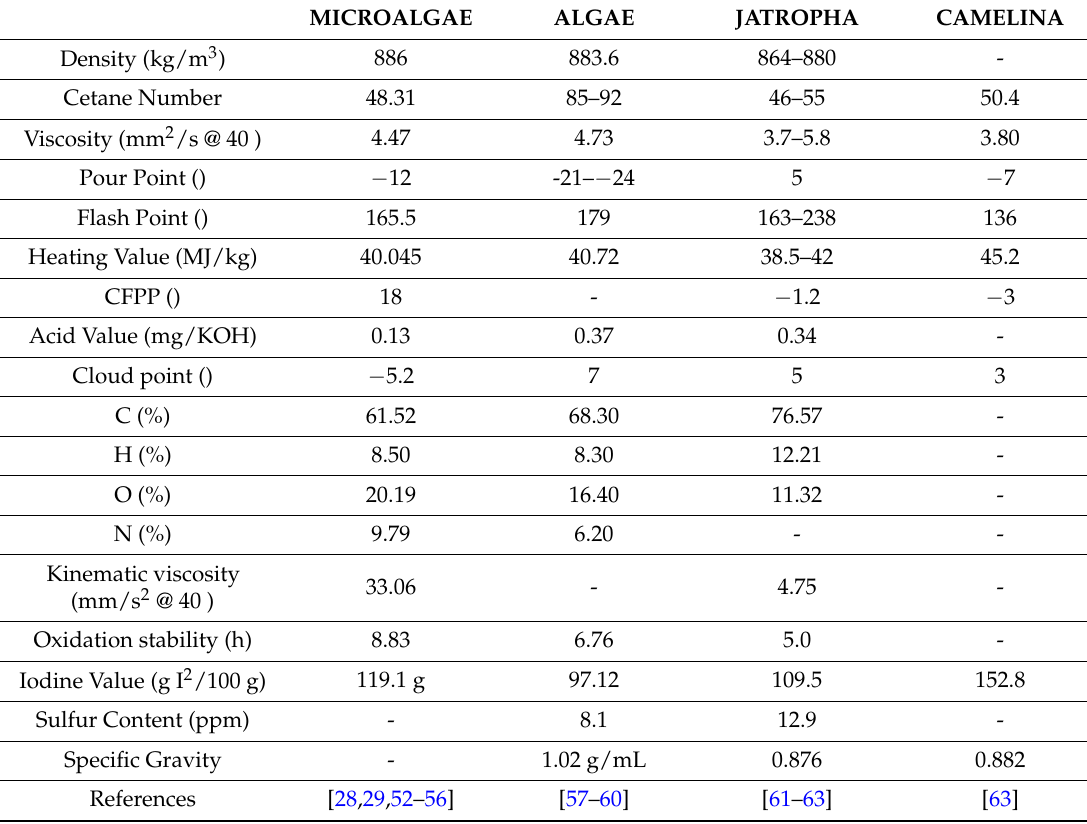
Table A1. Thermochemical properties for alternative fuels